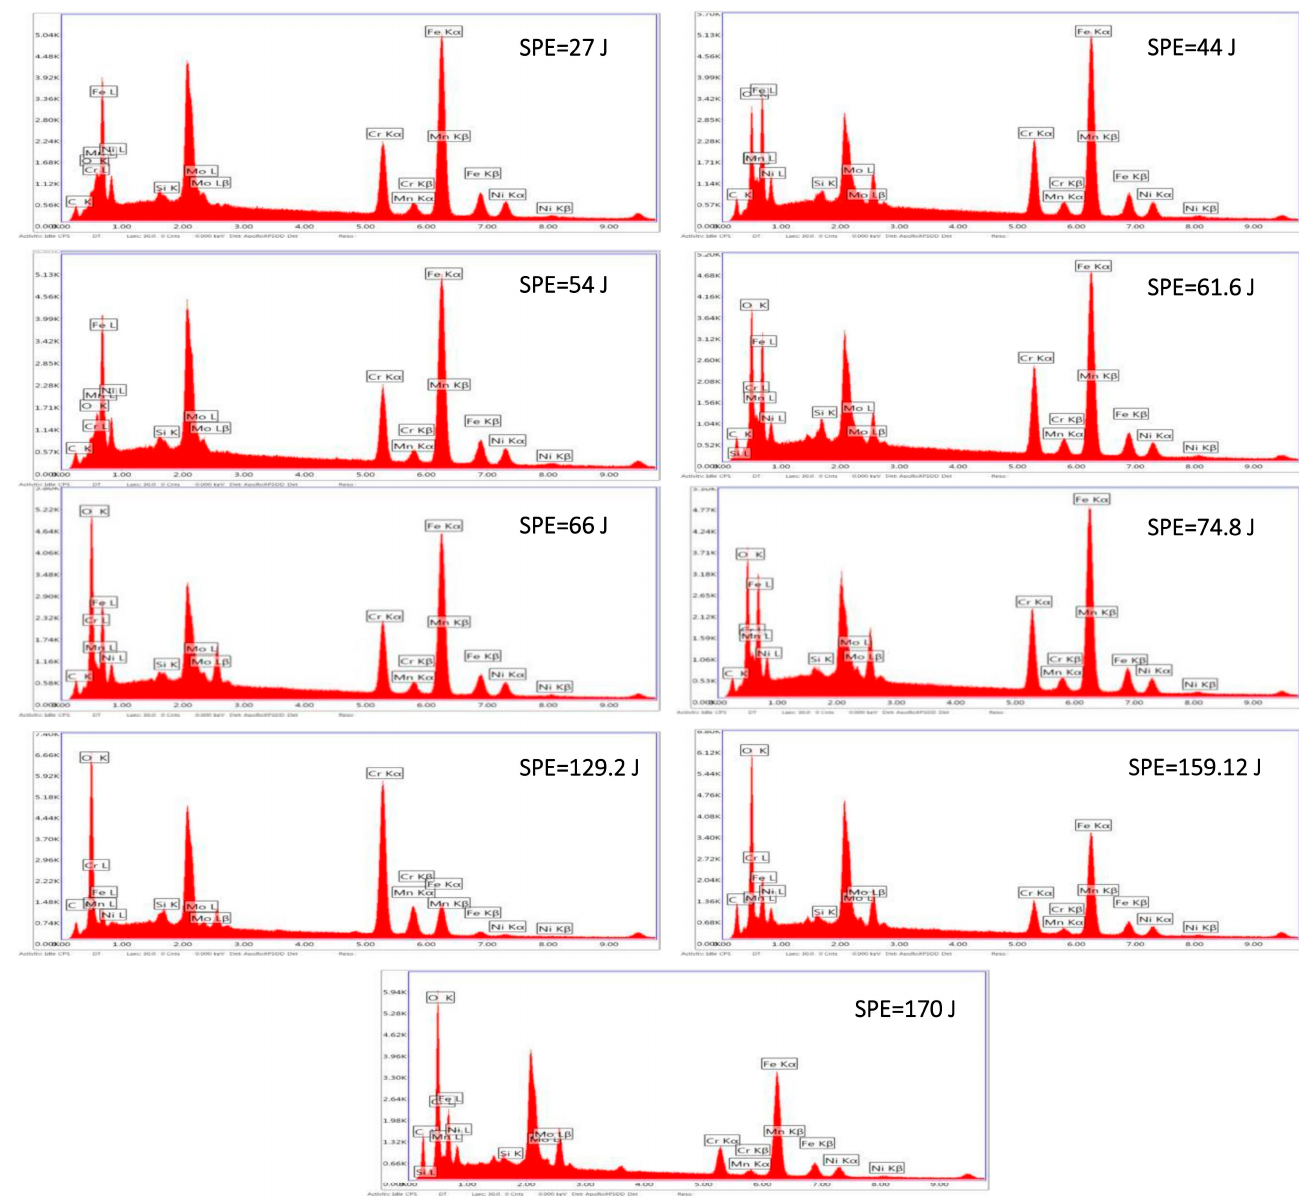
Figure 9. EDS images of the 316L weldment in serum